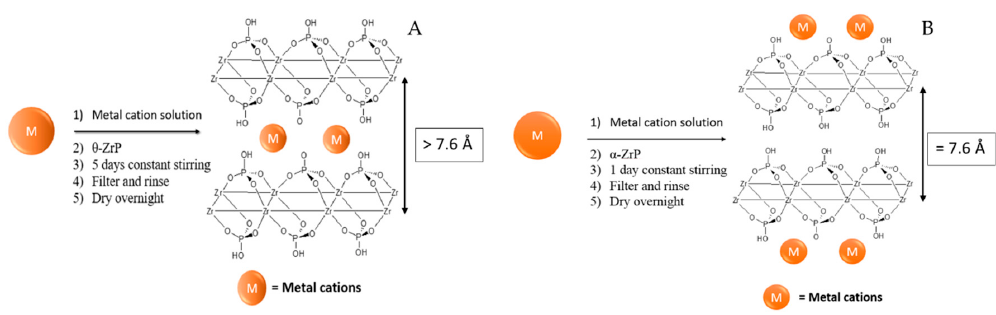
Figure 8. Schematic representation of the preparation procedure of ( A ) metal-intercalated and ( B ) surface adsorbed ZrP catalysts.